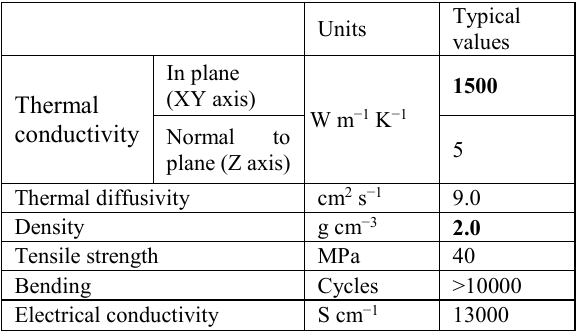
Table 1. Characteristics of the KANEKA